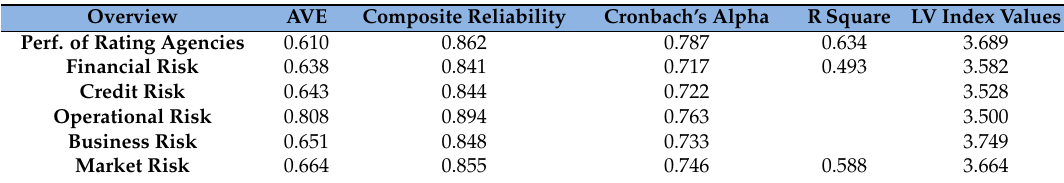
Table 3. Reliability Validation for the Latent